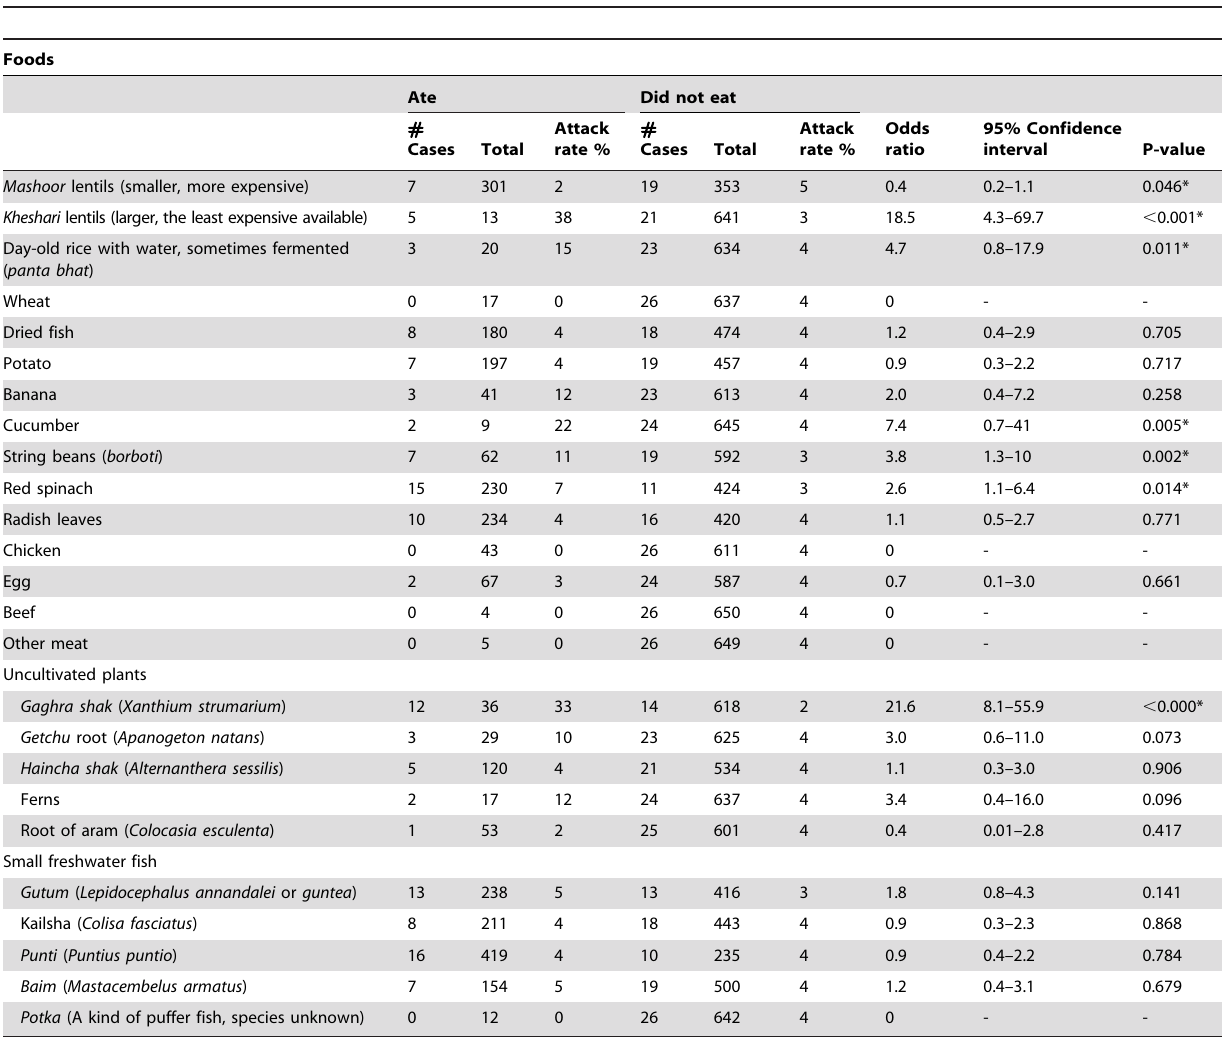
Table 2. Risk of experiencing vomiting with unconsciousness (N= 26) in two villages during the outbreak period by type of food